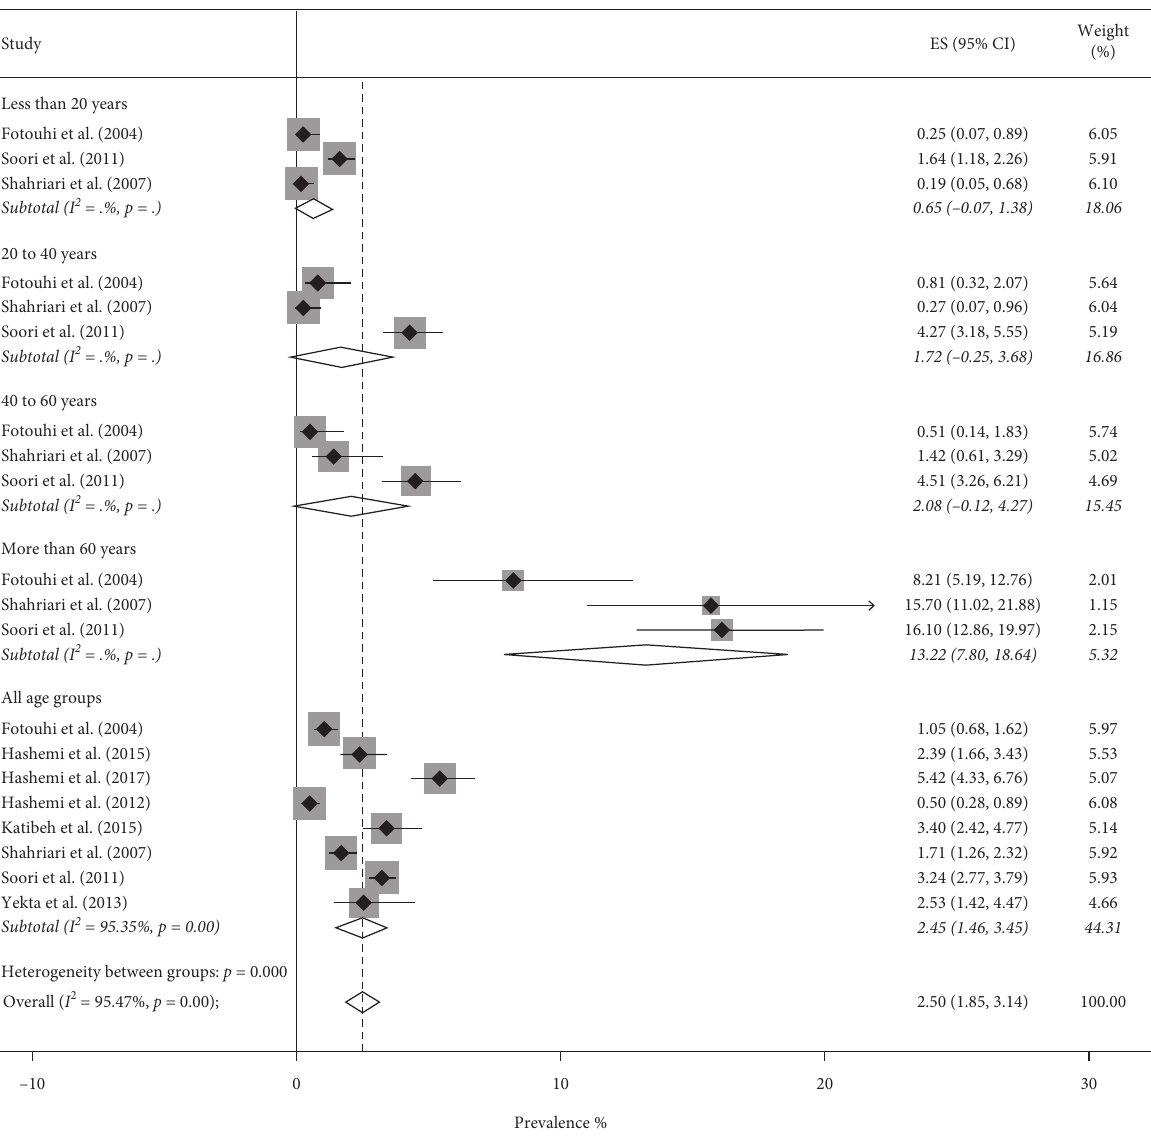
Figure 4: Forest plot of the prevalence of low vision among Iranian